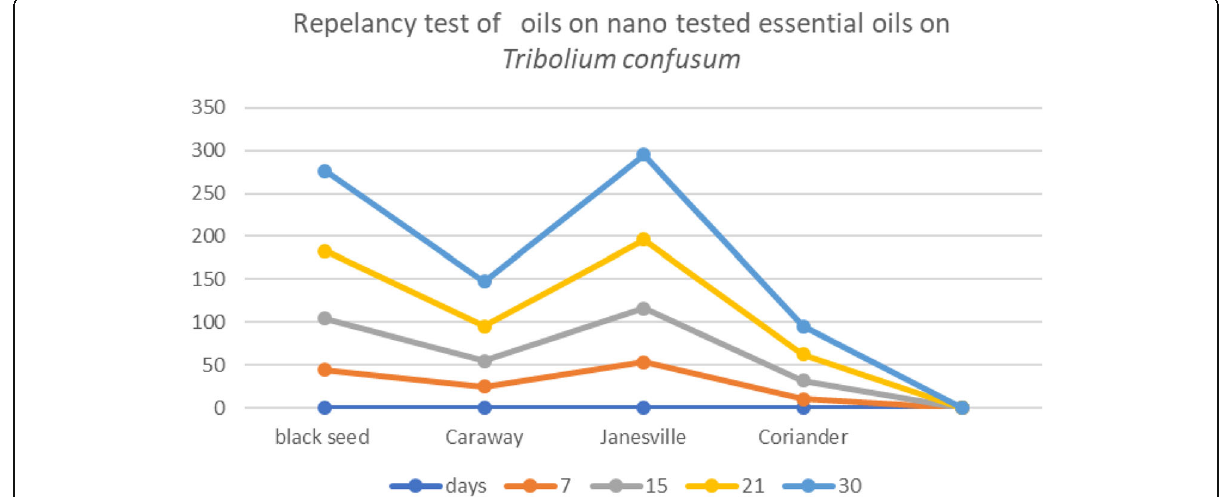
Fig. 2 The activity of the tested essential nano-oils on Tribolium